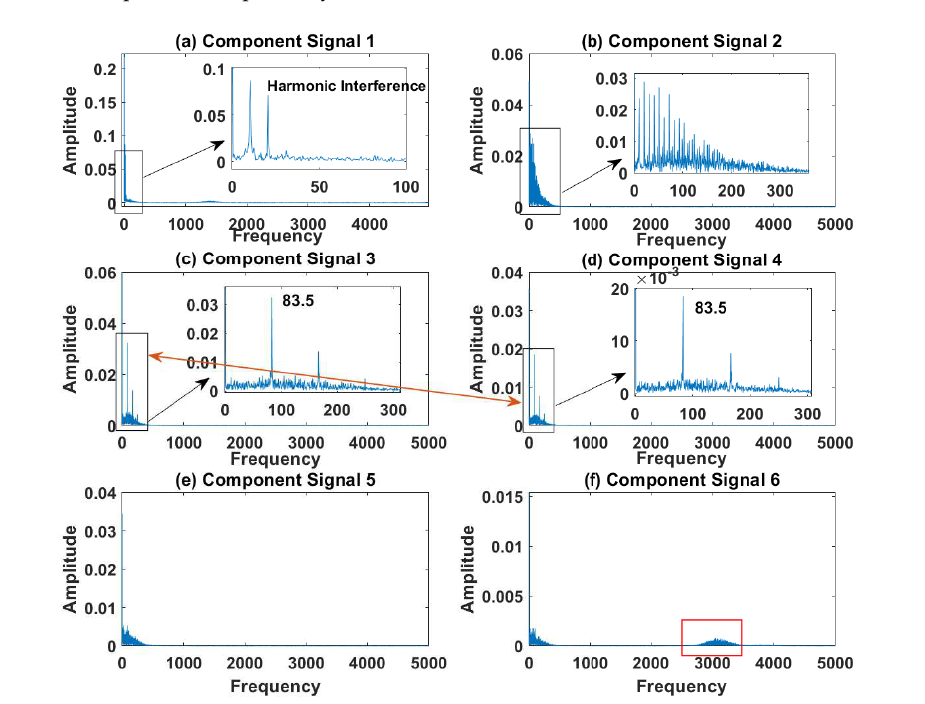
Figure 13. Decomposition results of FESVDP with m = 16 and J = 3: ( a – f ) envelop of 1st to 6th subcomponents,